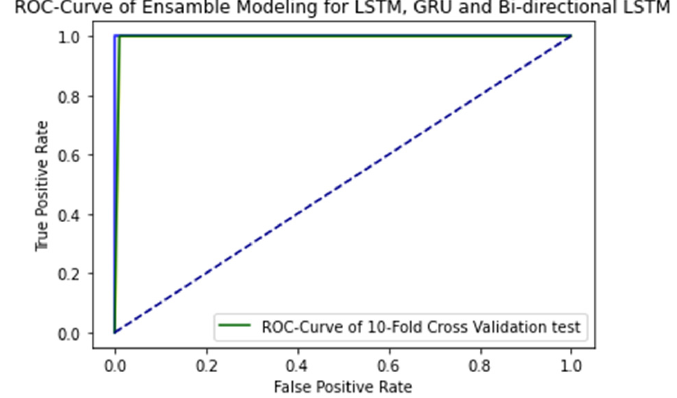
Figure 7. ROC Curve of proposed ensemble learning model with 10-fold Cross validation test.